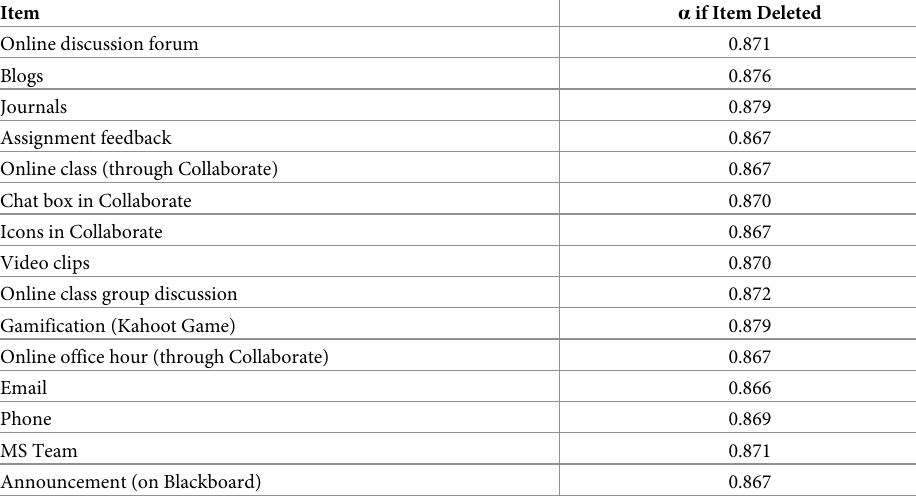
Table 1. Results of Cronbach’s Alpha ( α ) after e deletion of each